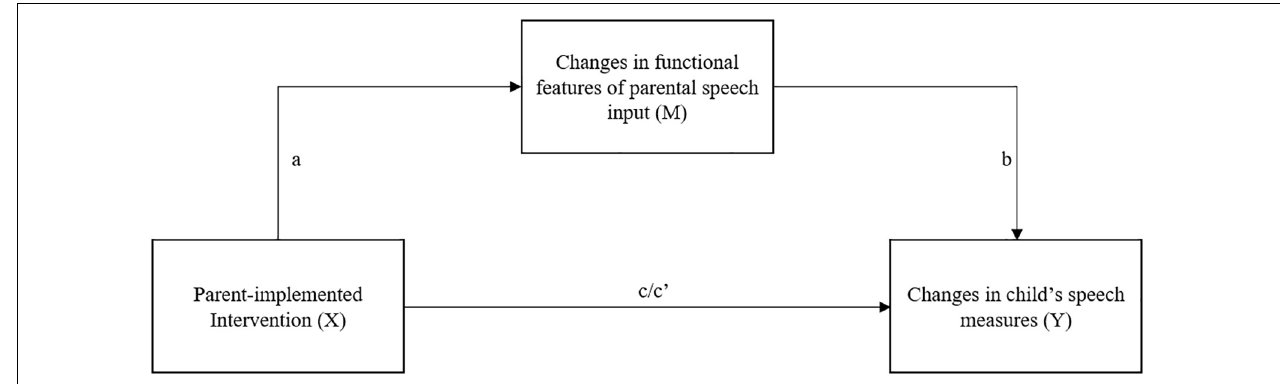
FIGURE 1 | Changes in functional features of parental speech input (M) operate mediationally between Parent-implemented Intervention (X) and Changes in child’s speech measures